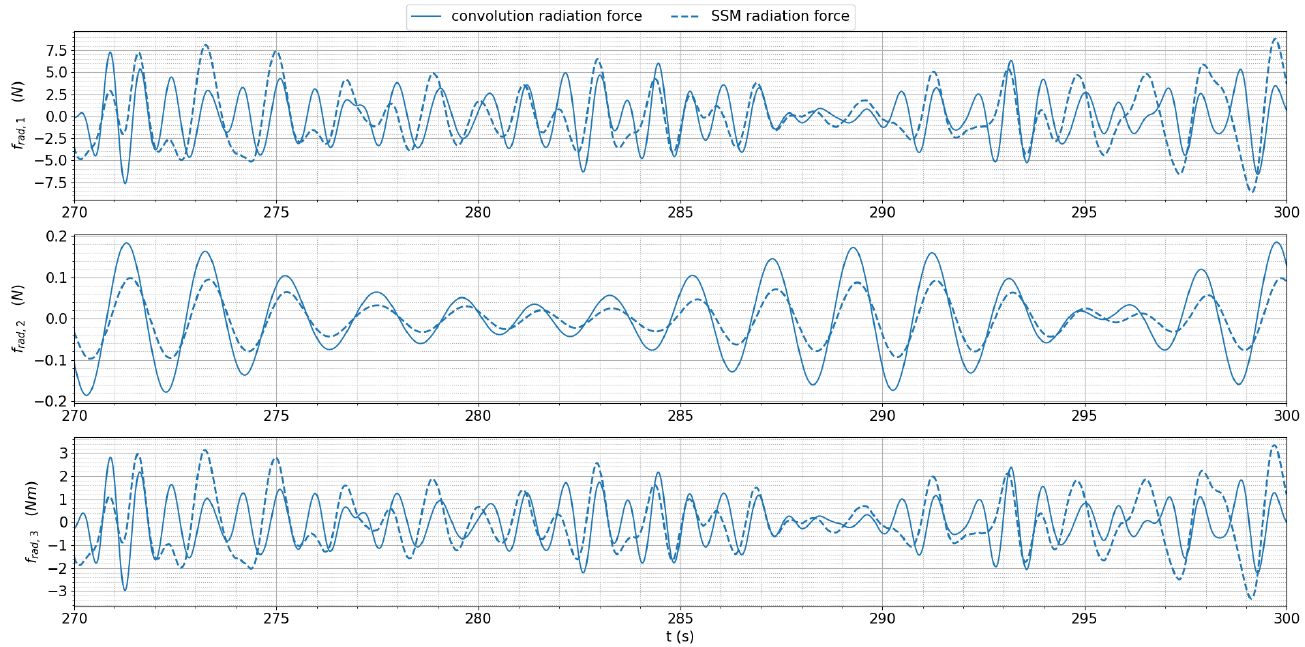
Figure 10. Comparison between convolution and SSM for the radiation